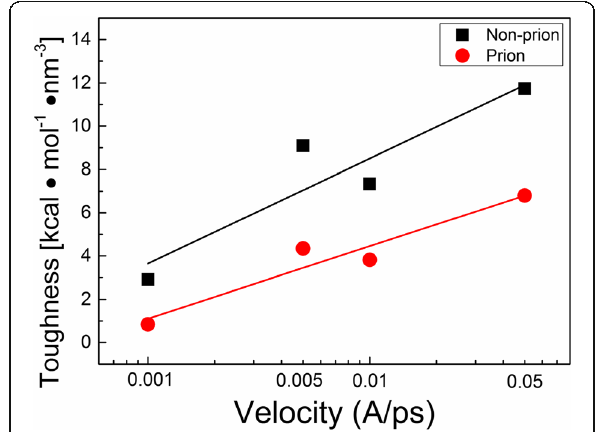
Fig. 6 Mechanical toughness of non-prion and prion fibrils as a function of pulling